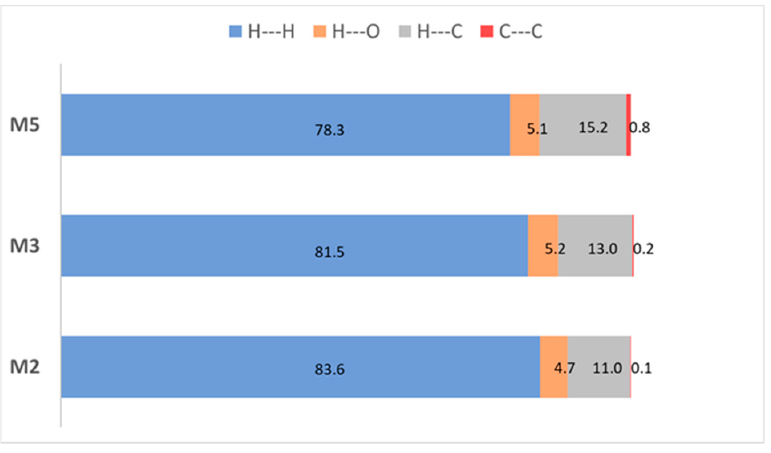
Figure 3. Views of crystal packings of M2 ( A ), M3 ( B ), and M5 ( C ). Independent molecules in the unit cells are colored. H atoms are omitted for clarity.